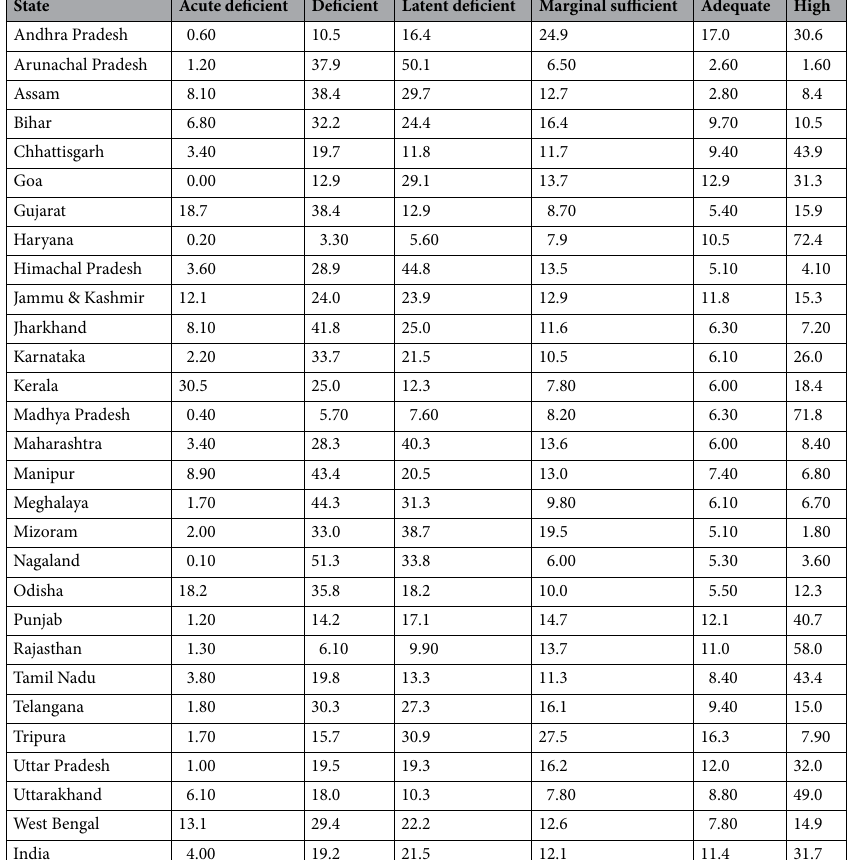
Table 4. State-wise deficiency (% of soil samples) status of available